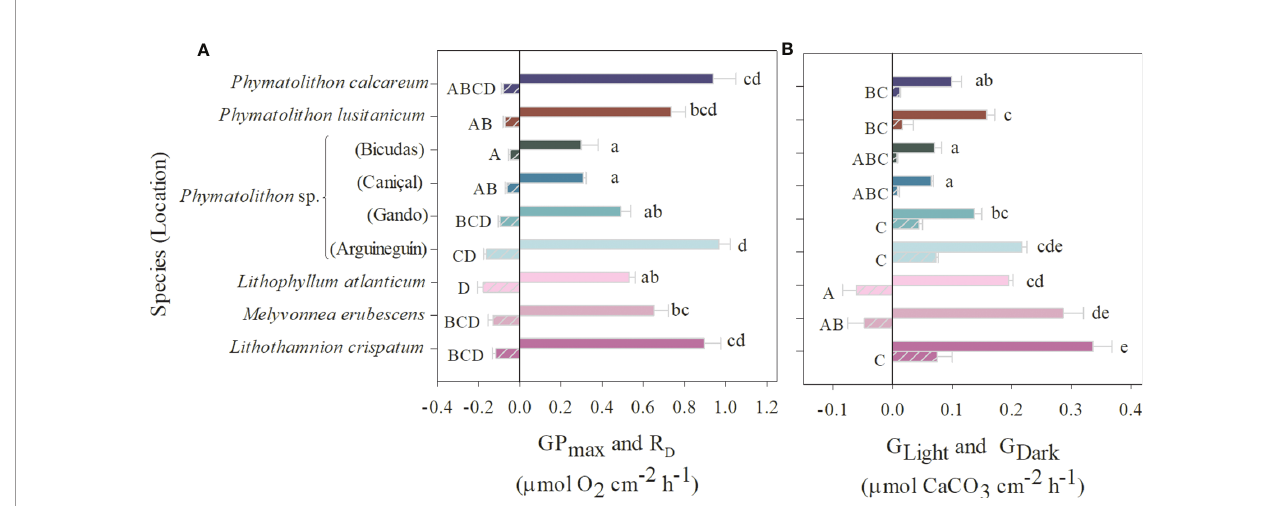
FIGURE 3 | Rhodolith physiological performance. (A) Maximum gross photosynthetic rates (GP max ) and dark respiration (R D , striped bars), and (B) maximum light calci fi cation (G Light ) and dark calci fi cation (G Dark , striped bars) of Atlantic rhodolith species (mean ± SE, n=5). Signi fi cant differences among species are indicated by different lowercase (GP max , G Light ) and uppercase (R D , G Dark ) letters (ANOVA, Tukey ’ s HSD posthoc, p<0.05). Data represent mean ± SE